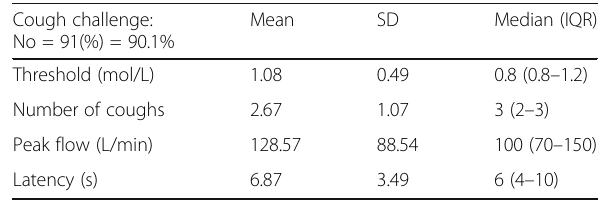
Table 2 Cough challenge for the whole